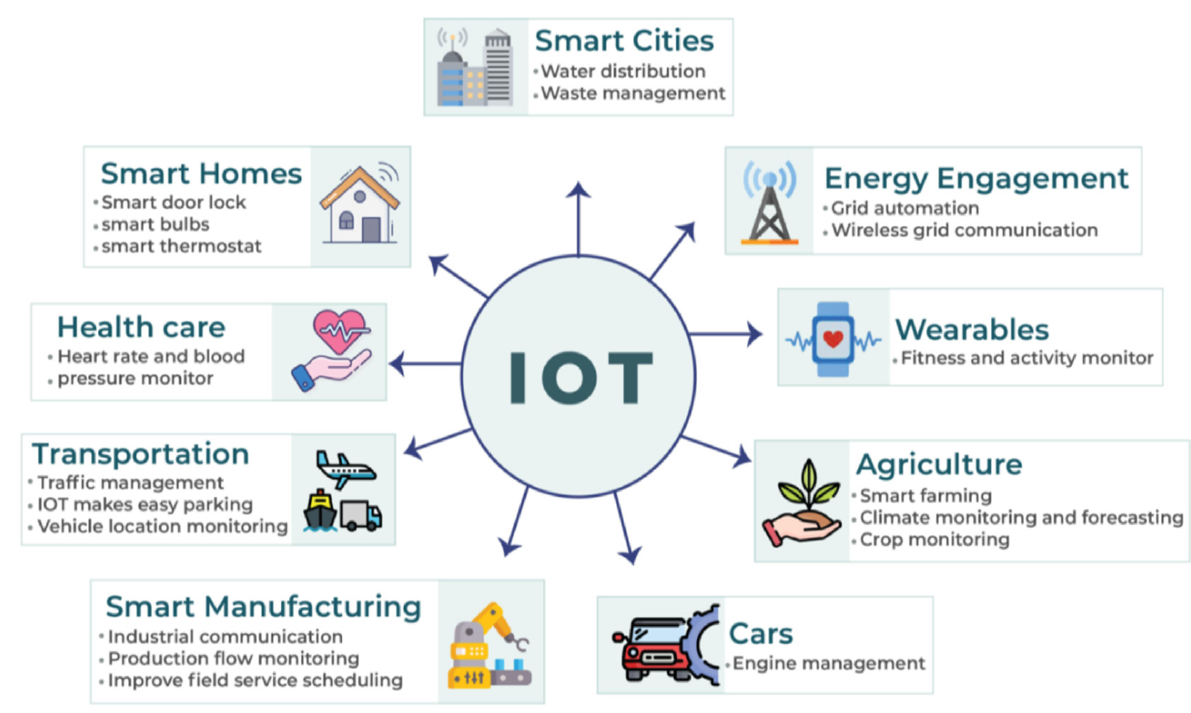
Figure 1. IoT applications and services.